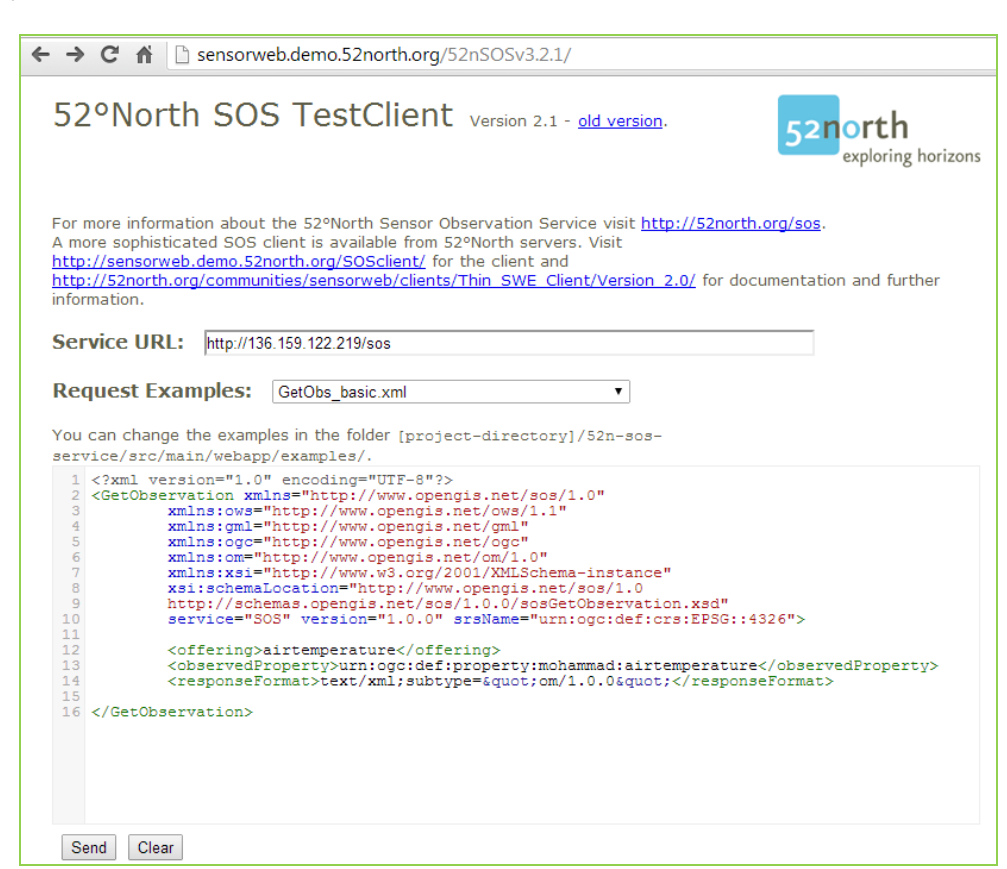
Figure A3. GetObservation request to TinySOS using the 52 North test client